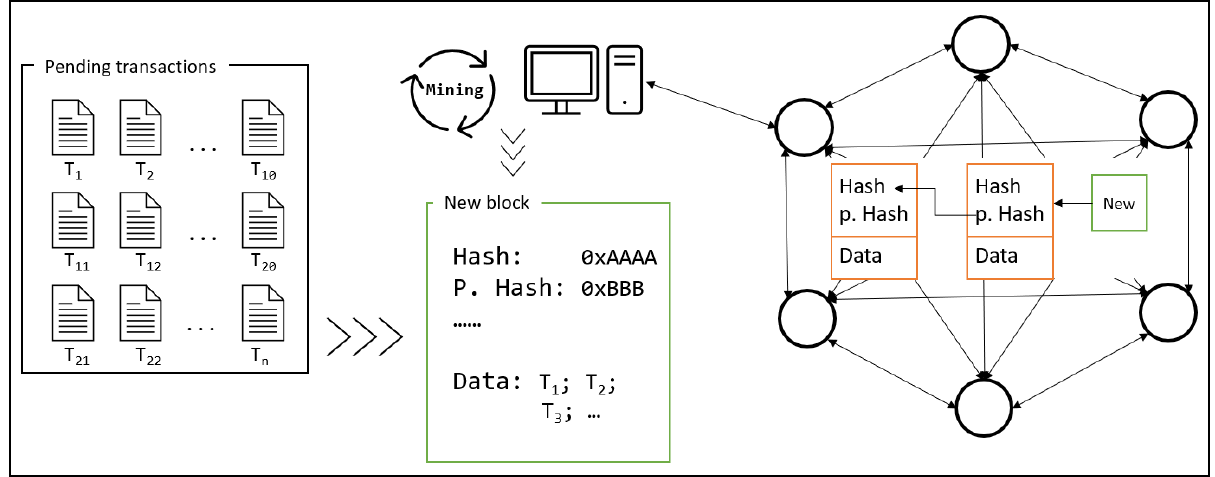
Figure 1. Traditional blockchain architecture.